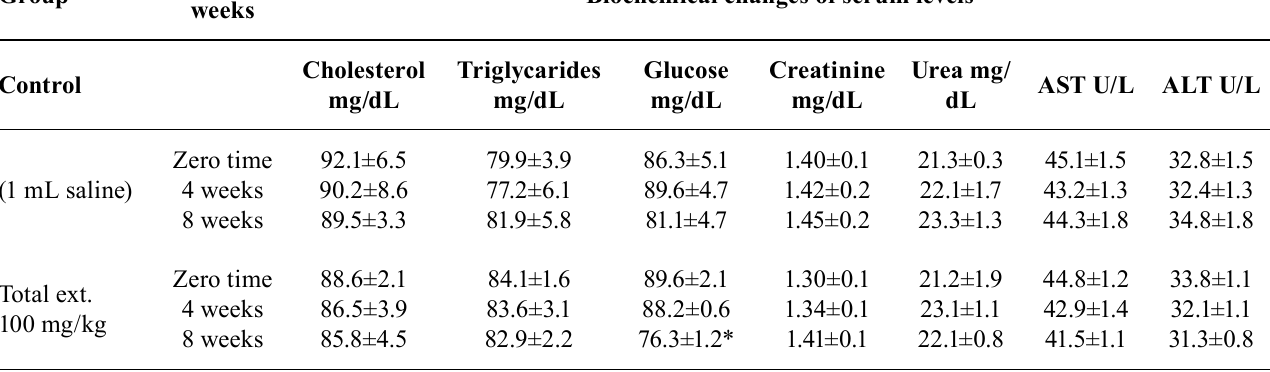
TABLE (III) – Effect of long term administration of TEE of A. fraxinifolius bark on cholesterol, triglycerides, glucose, creatinine, blood urea and liver enzymes (AST and ALT) serum levels in male albino rats